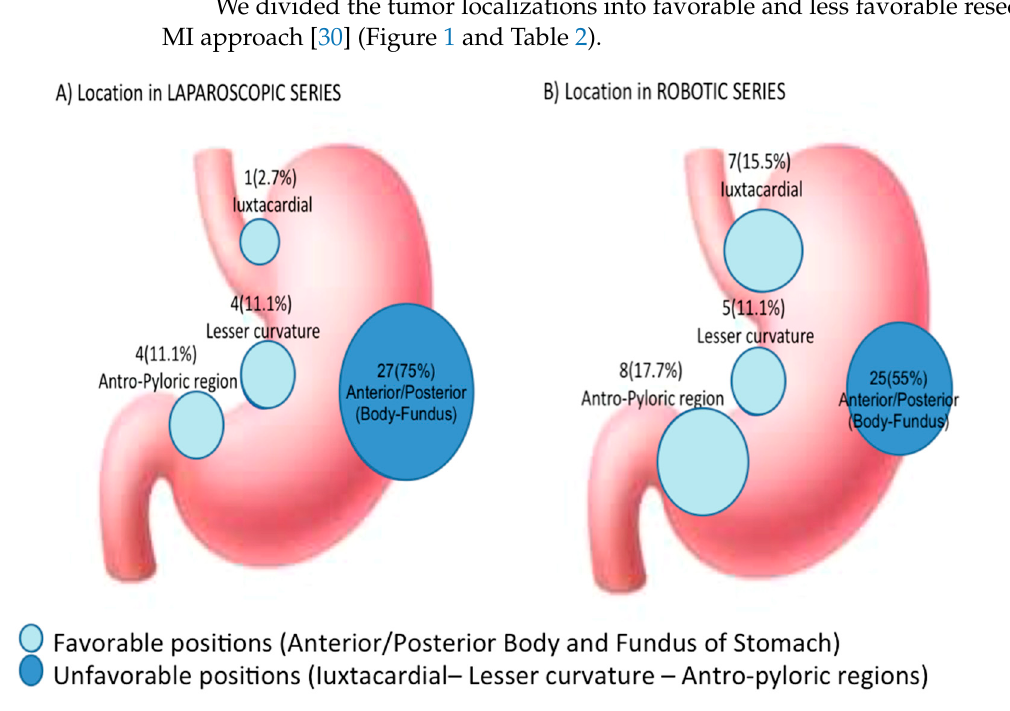
Figure 1. Favorable and unfavorable position of gastric GIST tumors. Table 2. Demographics and clinico-pathologic data of gastric GIST treated in the two series Robotic surgery (RS) and Laparoscopy (LS).